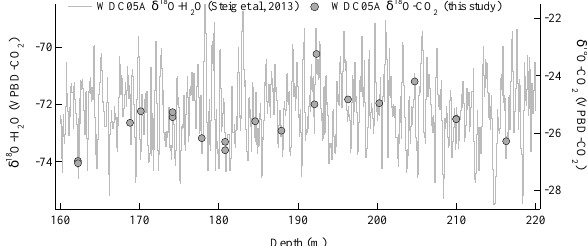
Figure 6. WAIS Divide δ 18 O-CO 2 and δ 18 O-H 2 O: a short selection of the δ 18 O-CO 2 (this study) and δ 18 O-H 2 O data (Steig et al., 2013) on the depth scale from the WDC05A core. The two vertical axes are of the same magnitude but offset to show the ability of δ 18 O- CO 2 to capture and integrate the fine scale δ 18 O-H 2 O.